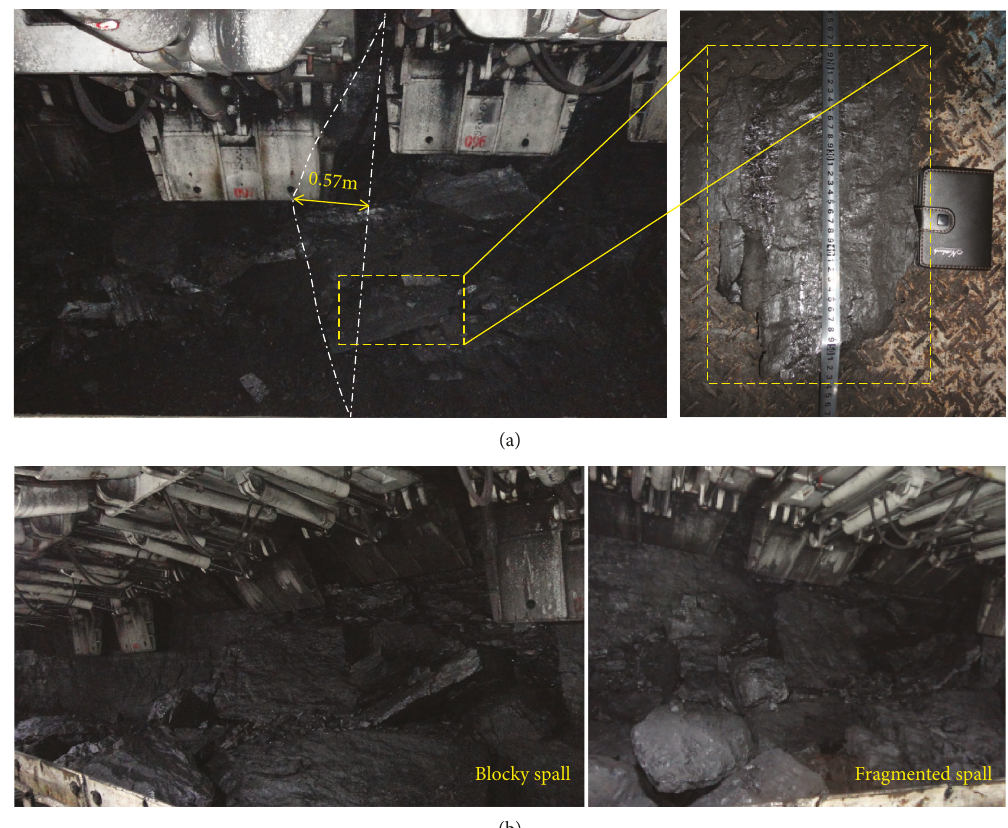
Figure 3: Observed tensile splitting failure (a) and shear slipping failure (b) in longwall face in a Chinese coal mine